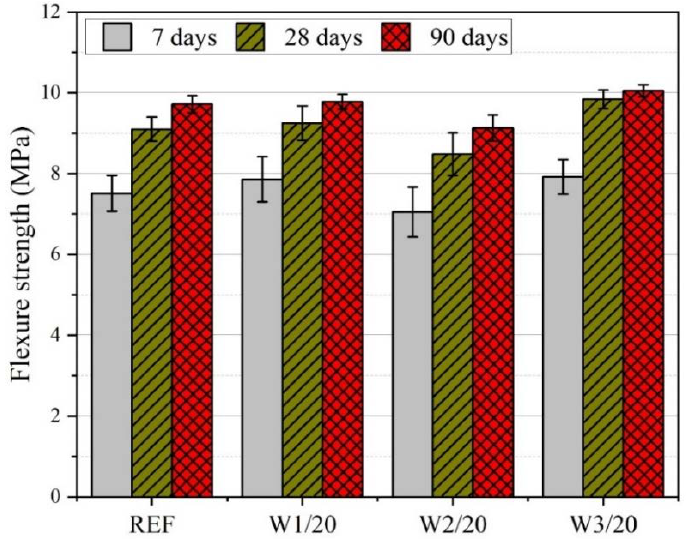
Figure 4. Flexure strength of mortar specimens.